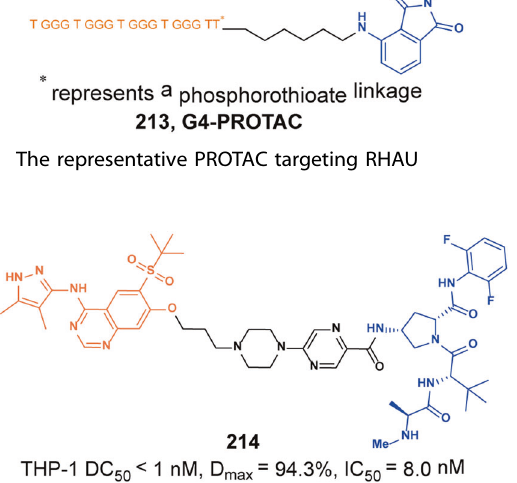
Fig. 67 The representative PROTAC targeting RIPK2